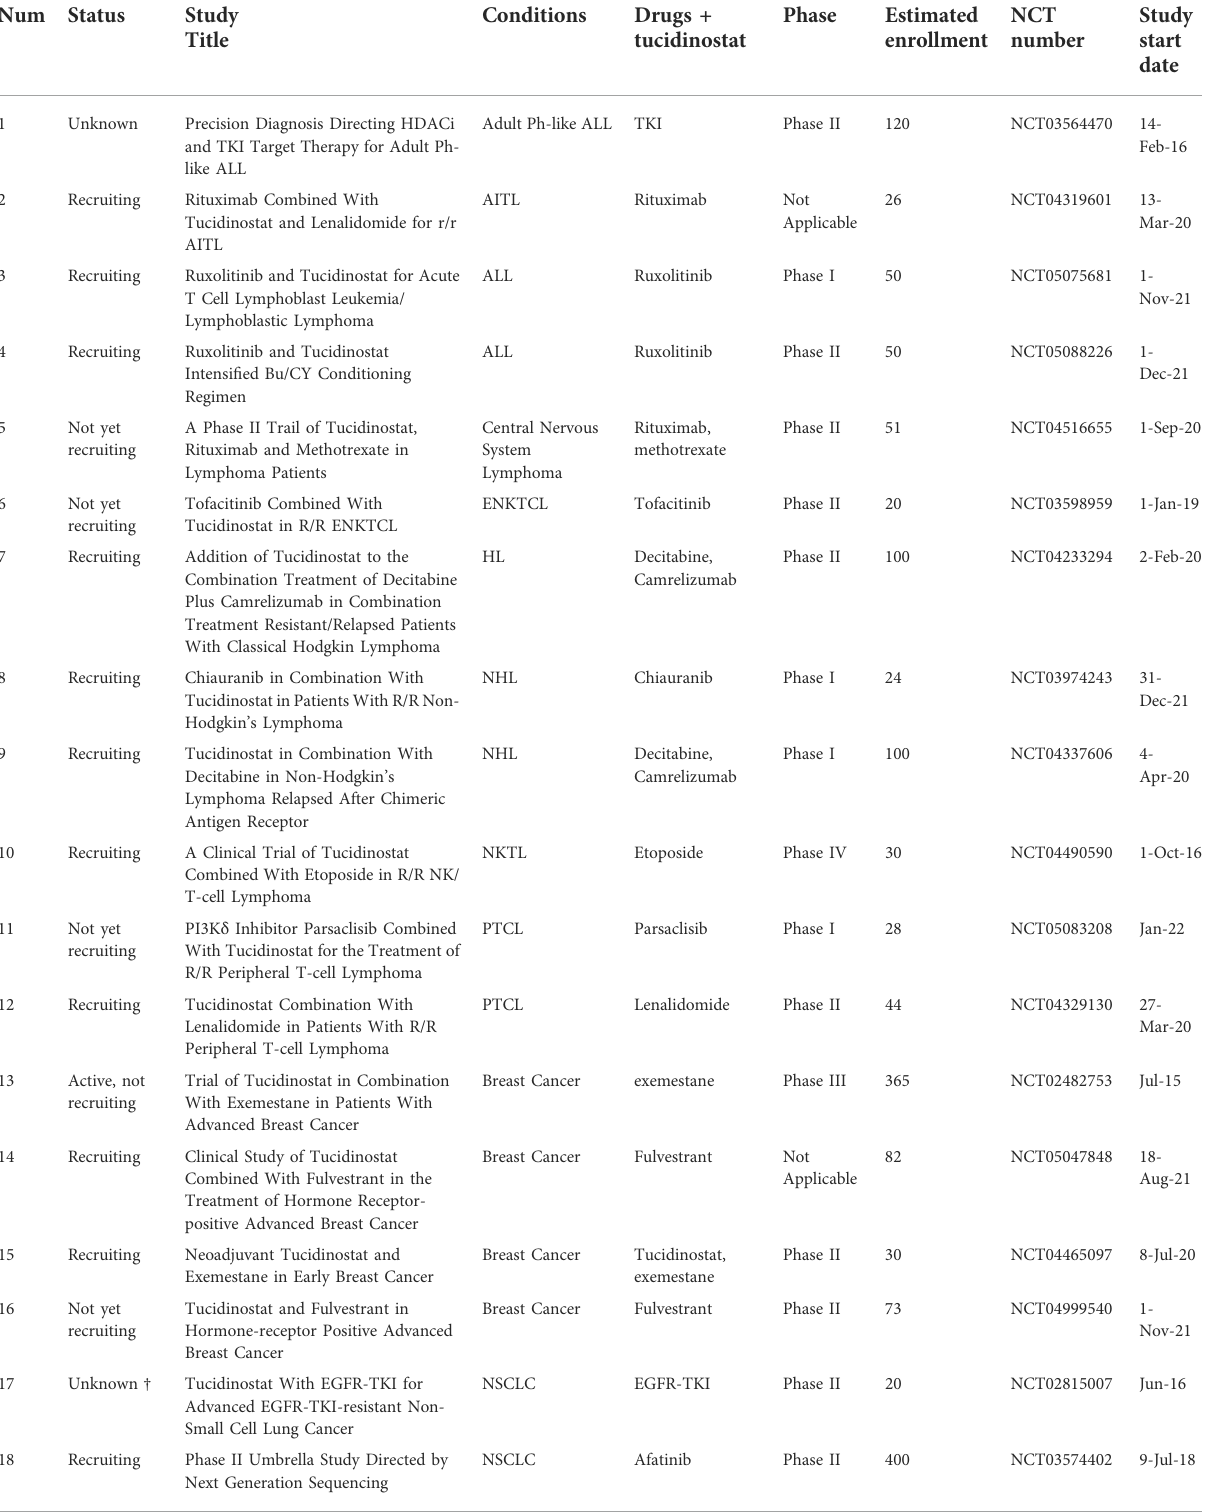
TABLE 4 Ongoing clinical trials of tucidinostat in combination with targeted